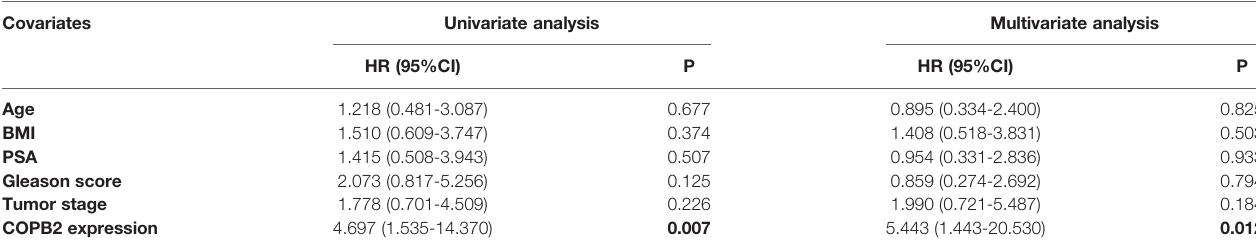
Bold values mean P <